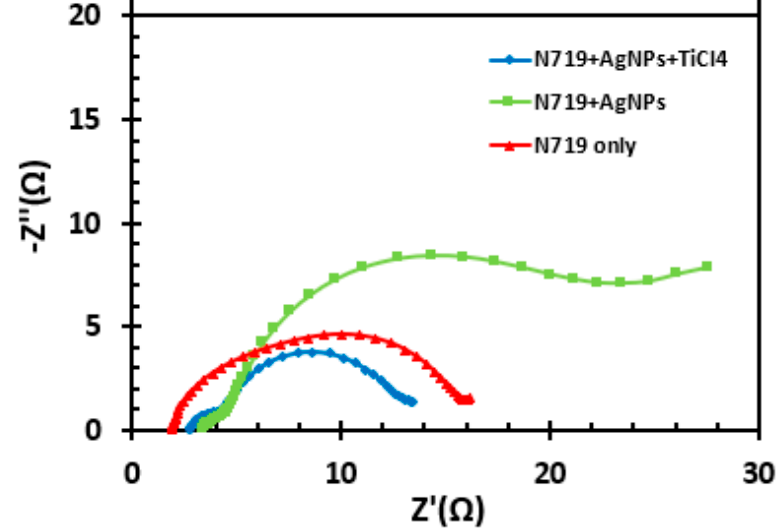
Figure 8. Nyquist plot of DSSCs fabricated with only N719, N719 with AgNPs treatment, and N719 with AgNP and TiCl 4 treatment.